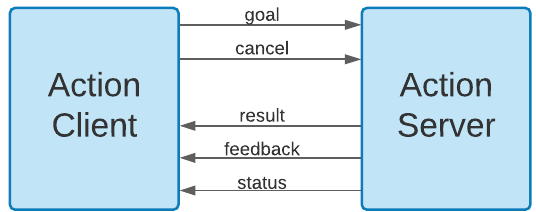
Figure 6. Robot Operating System (ROS) action